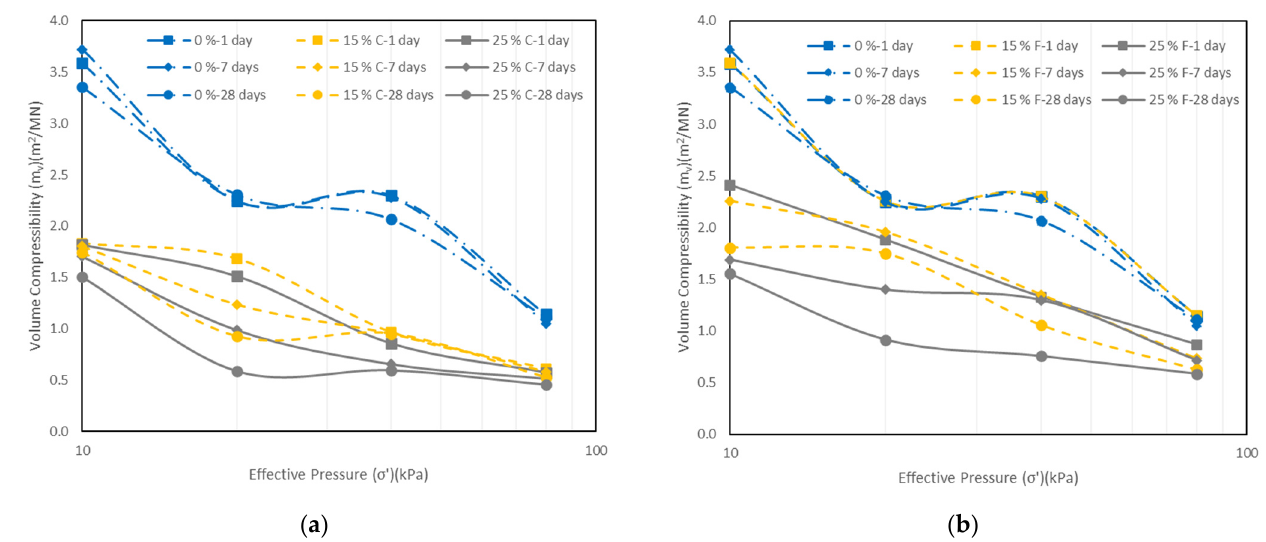
Figure 12. Variation of coefficient of m v with effective stress ( σ ’ ) for: ( a ) different class C fly ash contents, ( b ) different class F fly ash contents, and curing times.